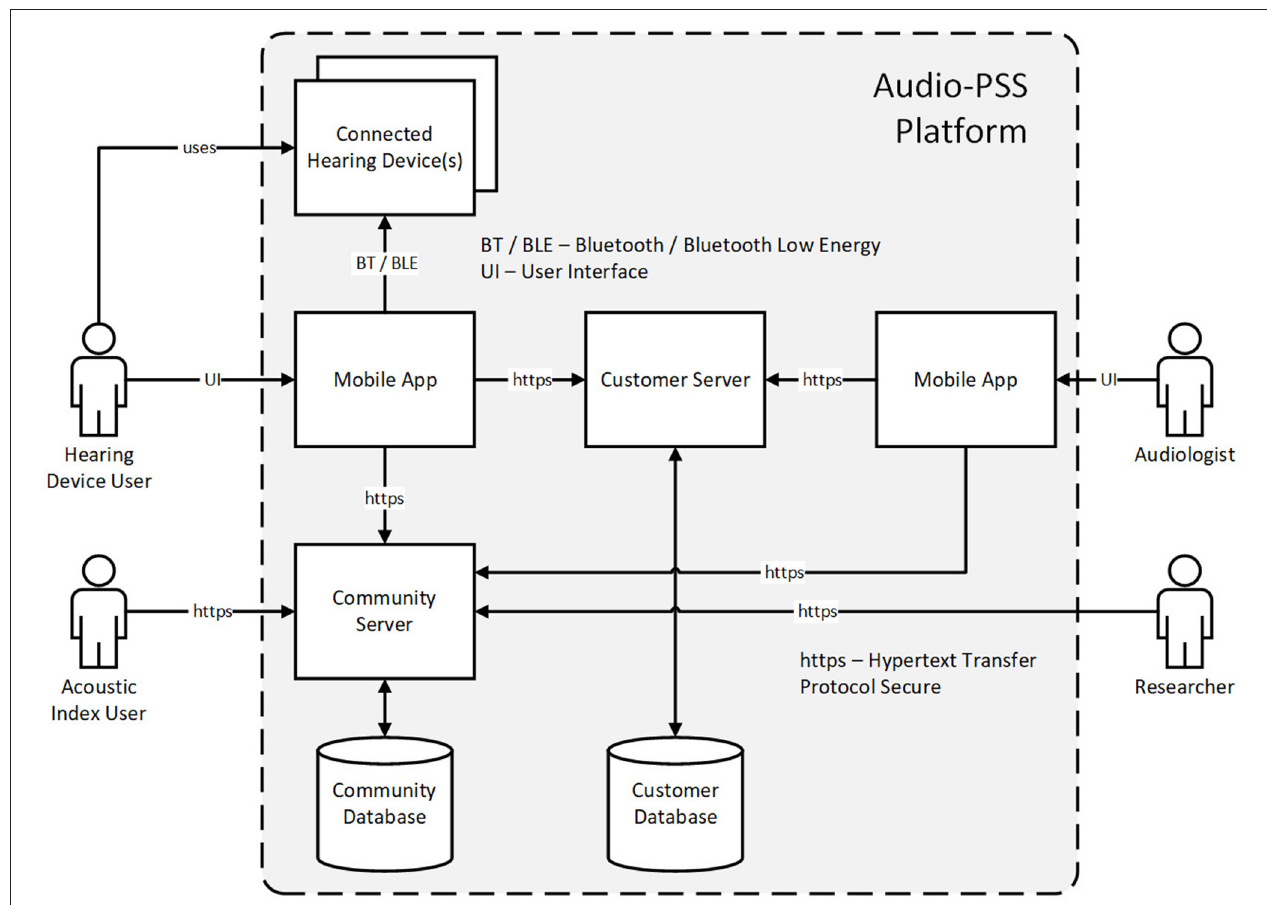
FIGURE 8 | Overview of the platform architecture to support 1:1, 1:N and N:M